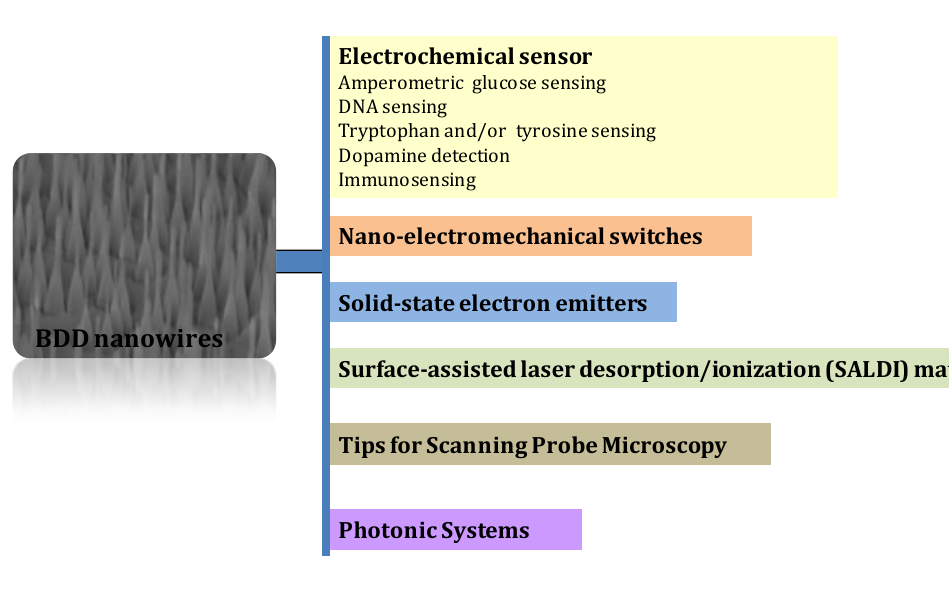
Figure 7. Applications of diamond